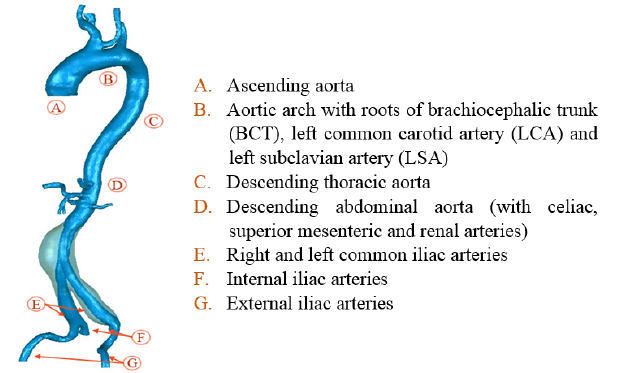
Figure 1. Finite element mesh of the aortic system with markers (A-G)